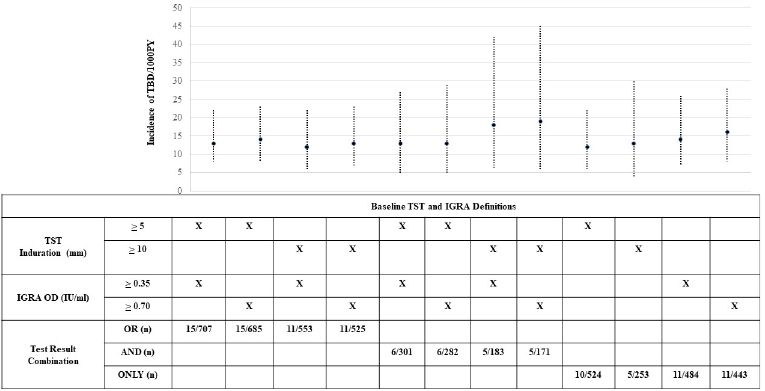
Fig 2. Incidence of TB disease among household contacts of adult pulmonary TB patients in India, stratified by TST and/or IGRA cut offs used to define baseline TB infection. Line graph depicting the incident TB disease (iTBD) rates among household contacts (HHC) of adult pulmonary TB (PTB) patients in India, stratified using different TST and/or IGRA cut offs to define the baseline TB infection (TBI) status. The graph shows that the iTBD rates were similar irrespective of the individual test cut off used to define baseline TBI, and irrespective of whether the definition used both a positive TST and IGRA test (“AND”) or either test alone